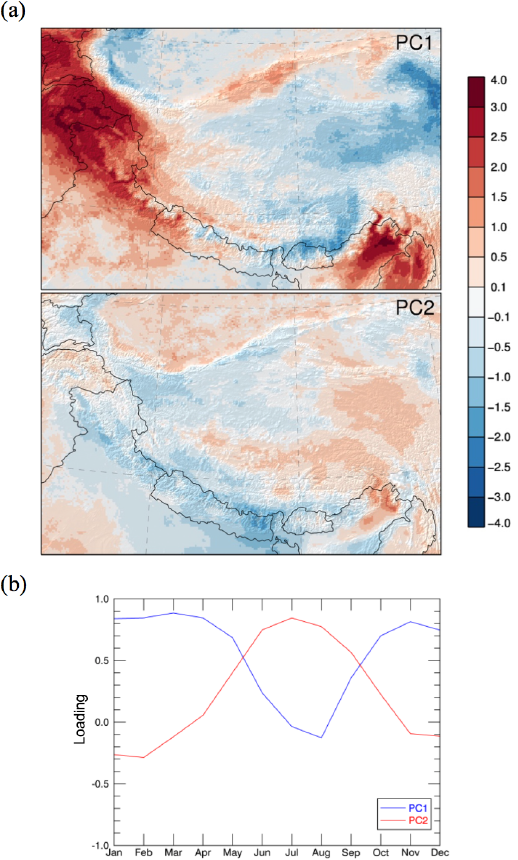
Figure 9. Scores of first two principal components PC1 and PC2 for the correlation between horizontal wind speed at model level 10 (WS10) and precipitation (a) (positive values are denoted in red, while negative values are denoted in blue) and the monthly loadings (b) for both